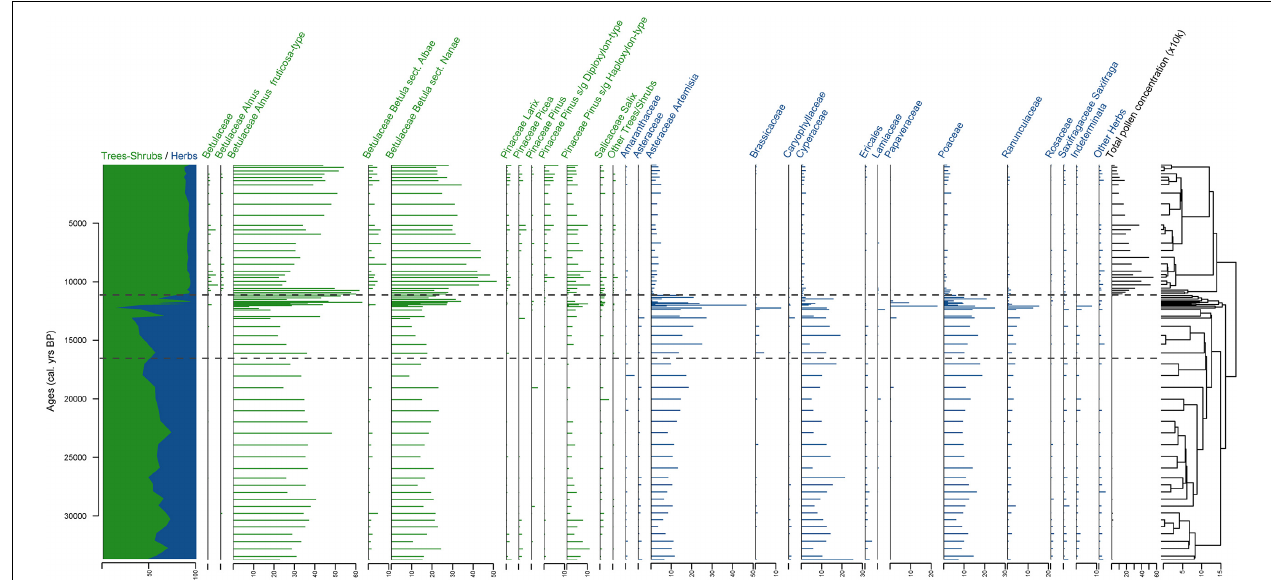
FIGURE 4 | Stratigraphic plot of terrestrial pollen with relative percentages of the taxa in each sample as horizontal bars, ratio of tree/shrub taxa vs herb taxa, and CONISS dendrogram. The taxa are sorted at genus level for trees and shrubs and at family level for herbs. Three pollen zones (PZ) are shown derived from the CONISS analysis. Samples from sediment core PG2133 are plotted against calibrated ages given in cal yr BP.